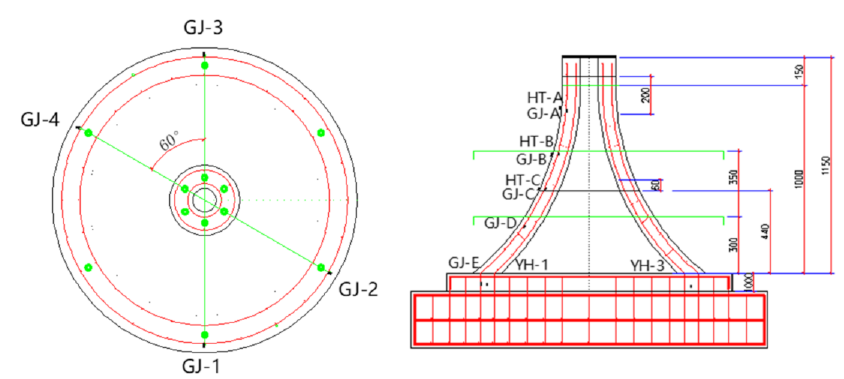
Figure 7. Schematic diagram of measuring point layout (units: